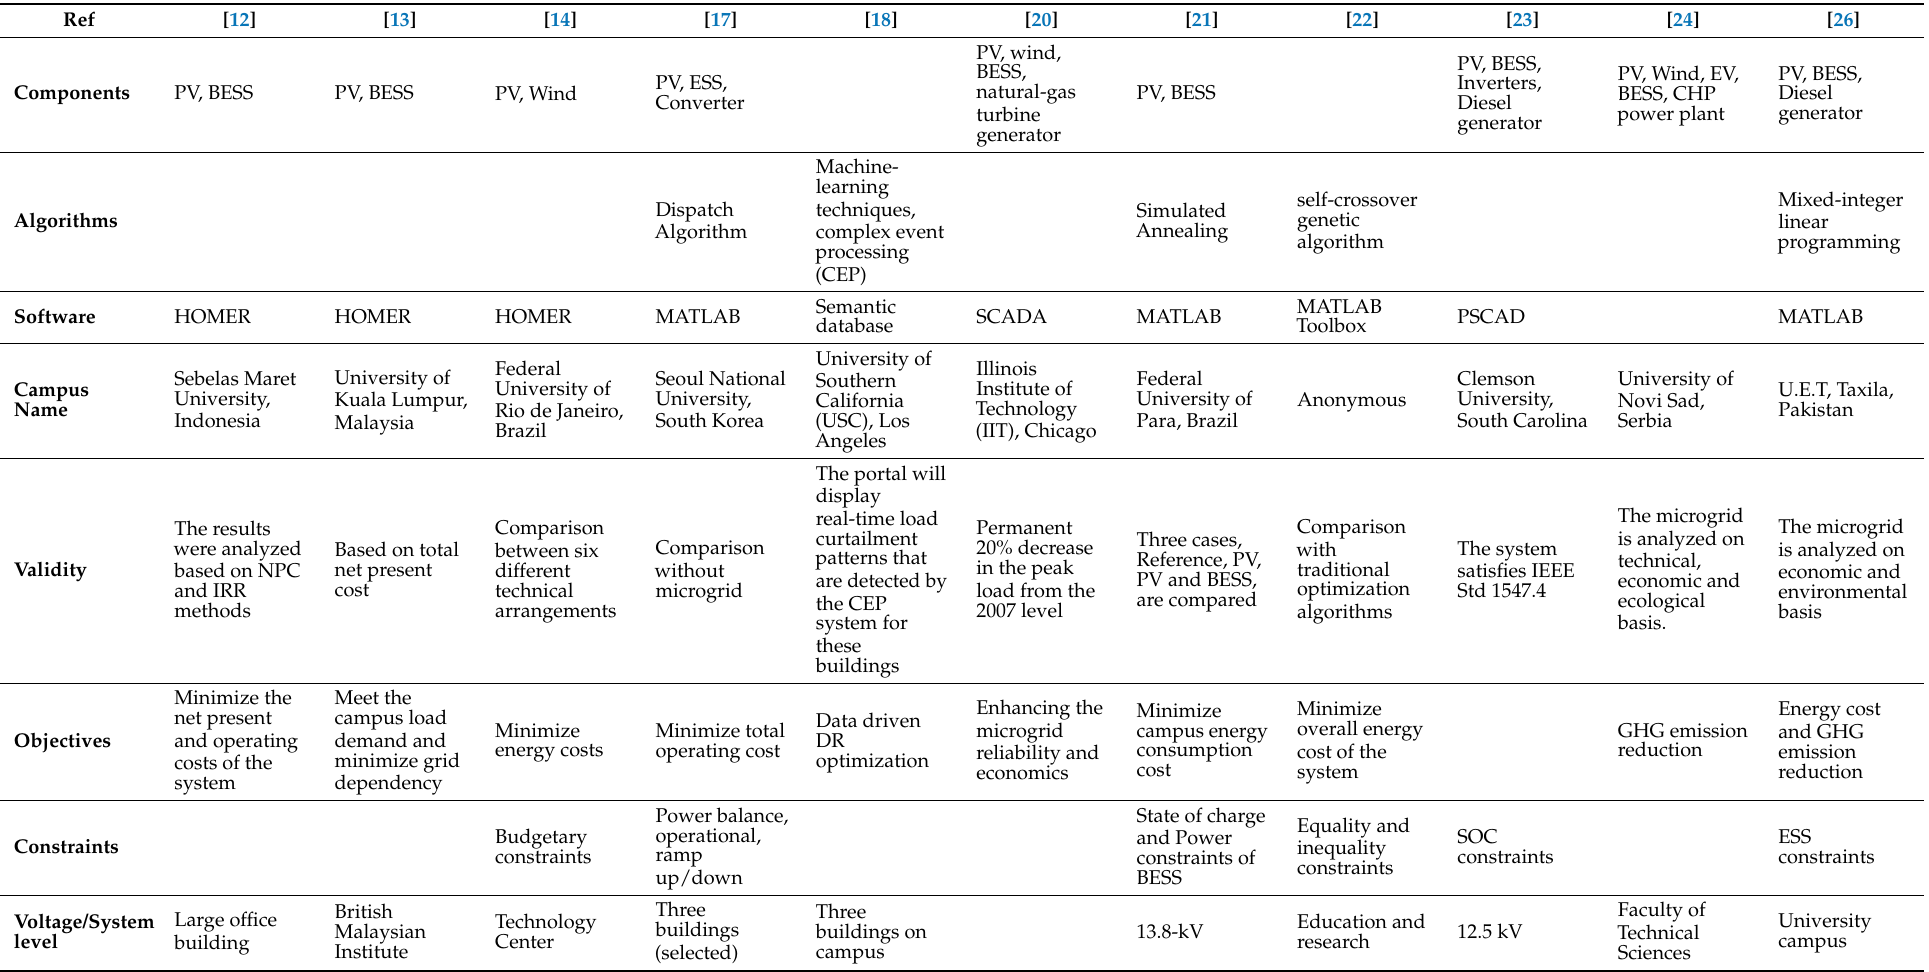
Table 1. Comparative study of related